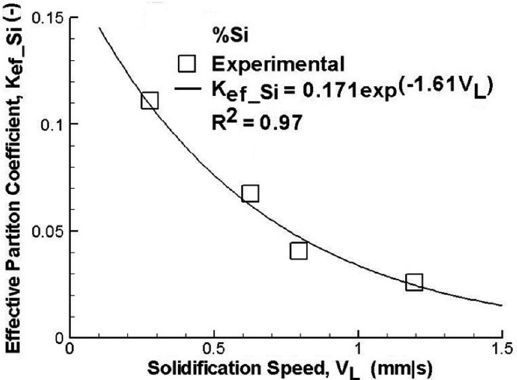
) versus solidification ef_Si